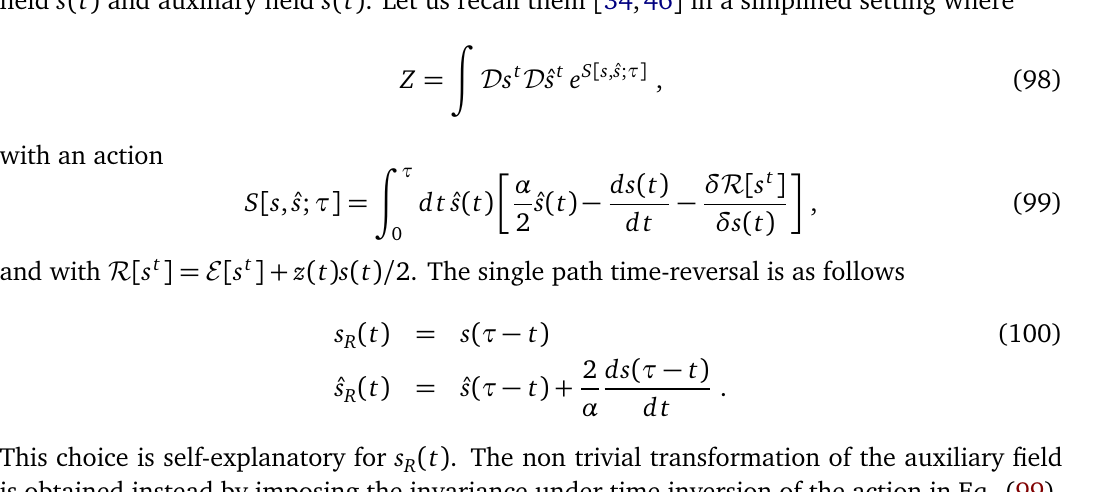
paths start from the energy of the saddle ε